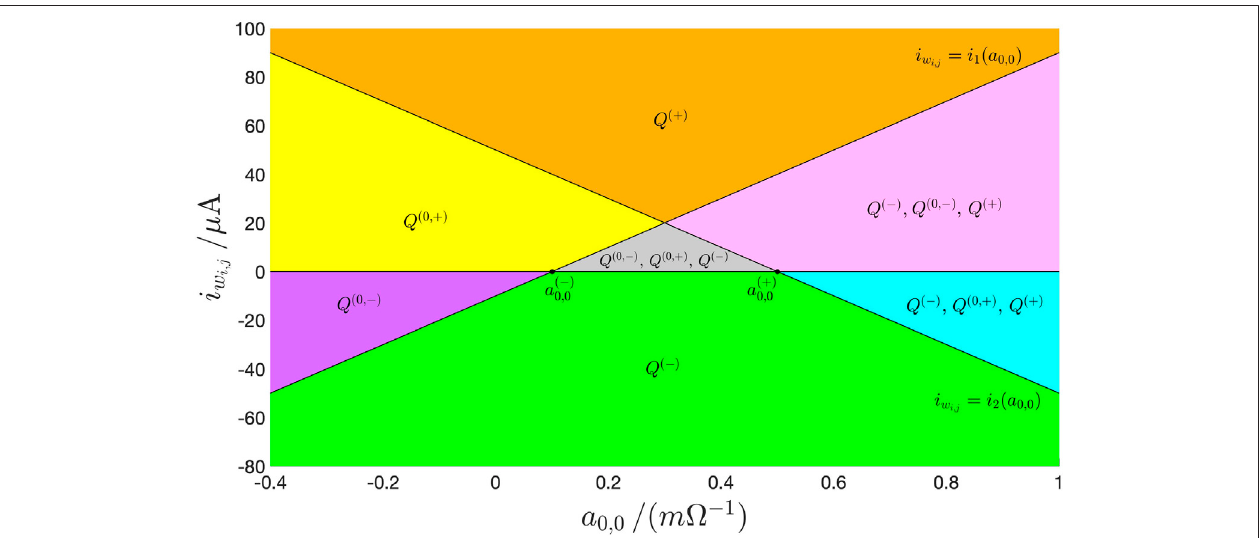
FIGURE 13 | The M-CNN Primary Mosaic : codimension-2 bifurcation diagram illustrating all the admissible equilibria the two states of the second-order cell from the class of uncoupled M-CNNs may approach asymptotically depending upon the speci fi c region of the a 0 , 0 – i w self-feedbacksynapticweightandtotheoffsetcurrentreside.Ared(black)colorisadoptedforthesymbolofeachunstable(stable)M-CNN cellequilibrium,asspeci fi ed in Table2 .Withoutlossofgenerality,here G x wassetto0 Ω − 1 .Thecoordinatesof Q (−) , Q ( 0 ) , Q ( 0 ) ,and Q (+) areindicatedin Eqs.39 , 41 , 43 ,and 45 .Theformulas for a (−) 0 , 0 , a (+) 0 , 0 , i 1 ( a 0 , 0 ) , and i 2 ( a 0 , 0 ) are respectively expressed by Eqs. 37 , 38 , 53 , and 54 . Details on the possible steady-state behaviours of the M-CNN cell in the (cid:1) 0A, i (cid:1) i ( a ) , and i (cid:1) i ( a ) have not been reported in the bifurcation diagram to keep the illustration as clear as possible. Importantly, as marginal cases i w w i , j 1 0 , 0 w i , j 2 0 , 0 i , j studied earlier, under zero offset current, irrespective of the value speci fi ed for a 0 , 0 , in the linear region the cell admits each equilibrium Q ( 0 ) , which, according to Eq. 47 , – v lies along the segment of the horizontal axis of the x m x i , j phase plane comprised between x on and x off i , j